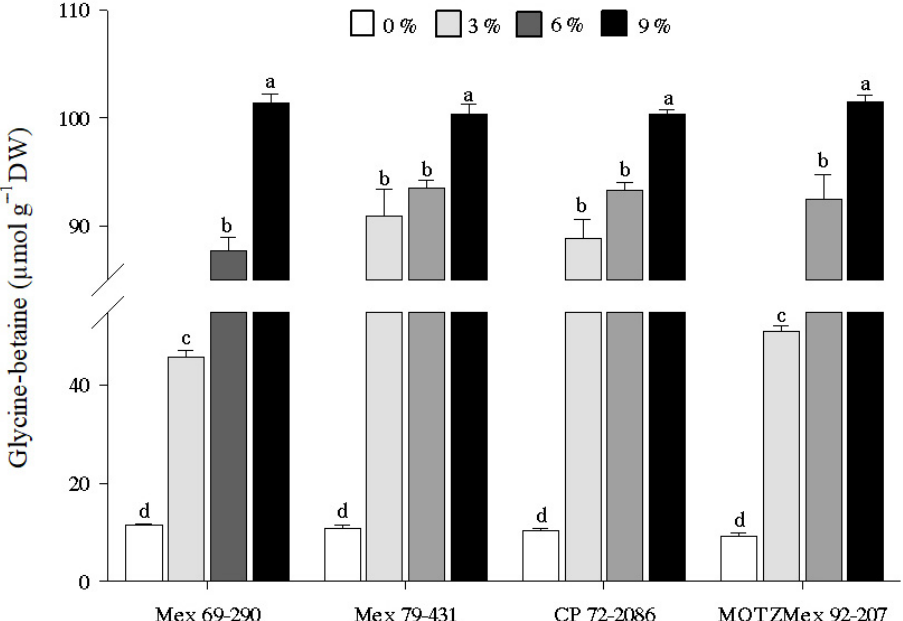
Figure 4. Effect of different concentrations of PEG-6000 on glycine-betaine content in sugarcane cultivars ( Saccharum spp. Hybrids). Bars above the columns represent the standard error. Different letters above the columns of each subfigure indicate significant statistical differences among treatments (Tukey, p ≤ 0.05).